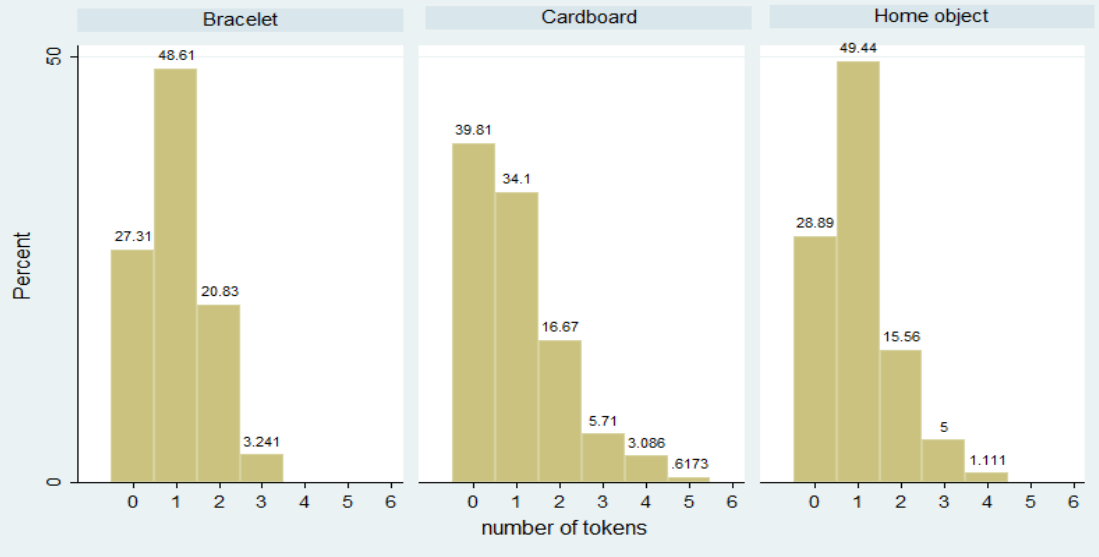
Figure 3. The number of tokens available.